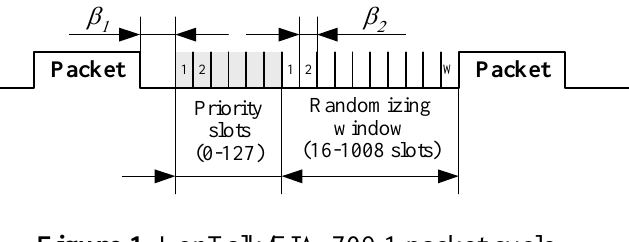
Figure 1. LonTalk/EIA-709.1 packet